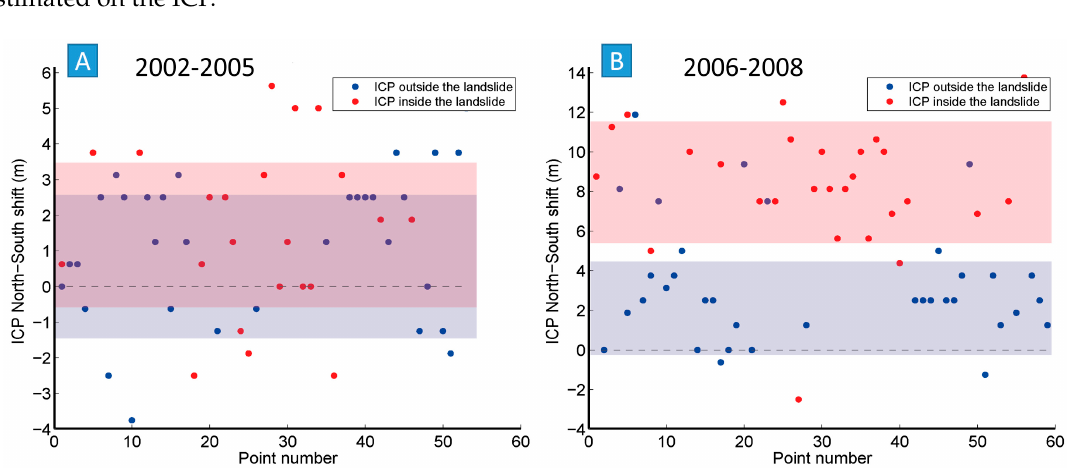
Figure 3. South-north shift of the ICP for the two periods of study. The points have been identified on successive images by SIFT [34]. The long axis of the pink rectangles (resp. blue rectangles) are located on the average shift value of the ICP located inside (resp. outside) the landslide. The width of the rectangles is equal to two times the standard deviation. ( A ) For the 2002–2005 period, the points located in the landslide display shifts similar to the points located out of the landslide. The difference between these shifts is not significant; ( B ) For the period 2006–2008, the points located in the landslide display a shift distinct from the shift of the points located out of the landslide. A clear signal of displacement is visible.